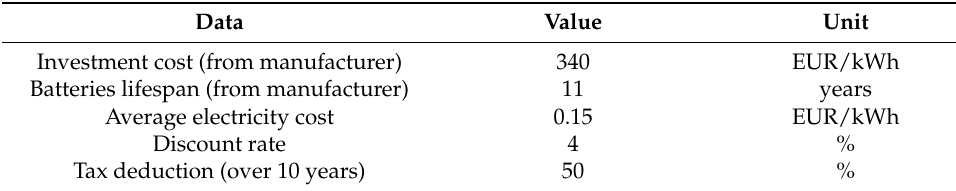
Table 12. Assumptions for economic